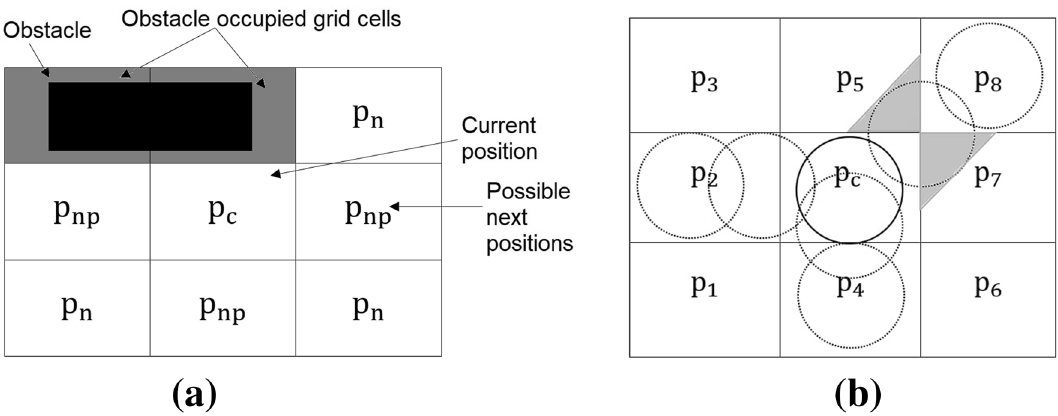
Fig. 1 a Structure of a grid based environment; b restriction of diagonal